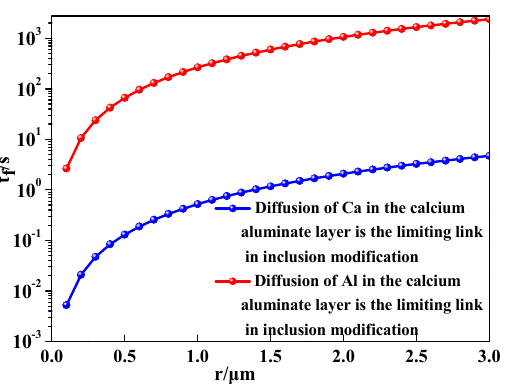
Figure 8. Diffusion of Ca and Al in the calcium aluminate layer is the limiting link of modification.